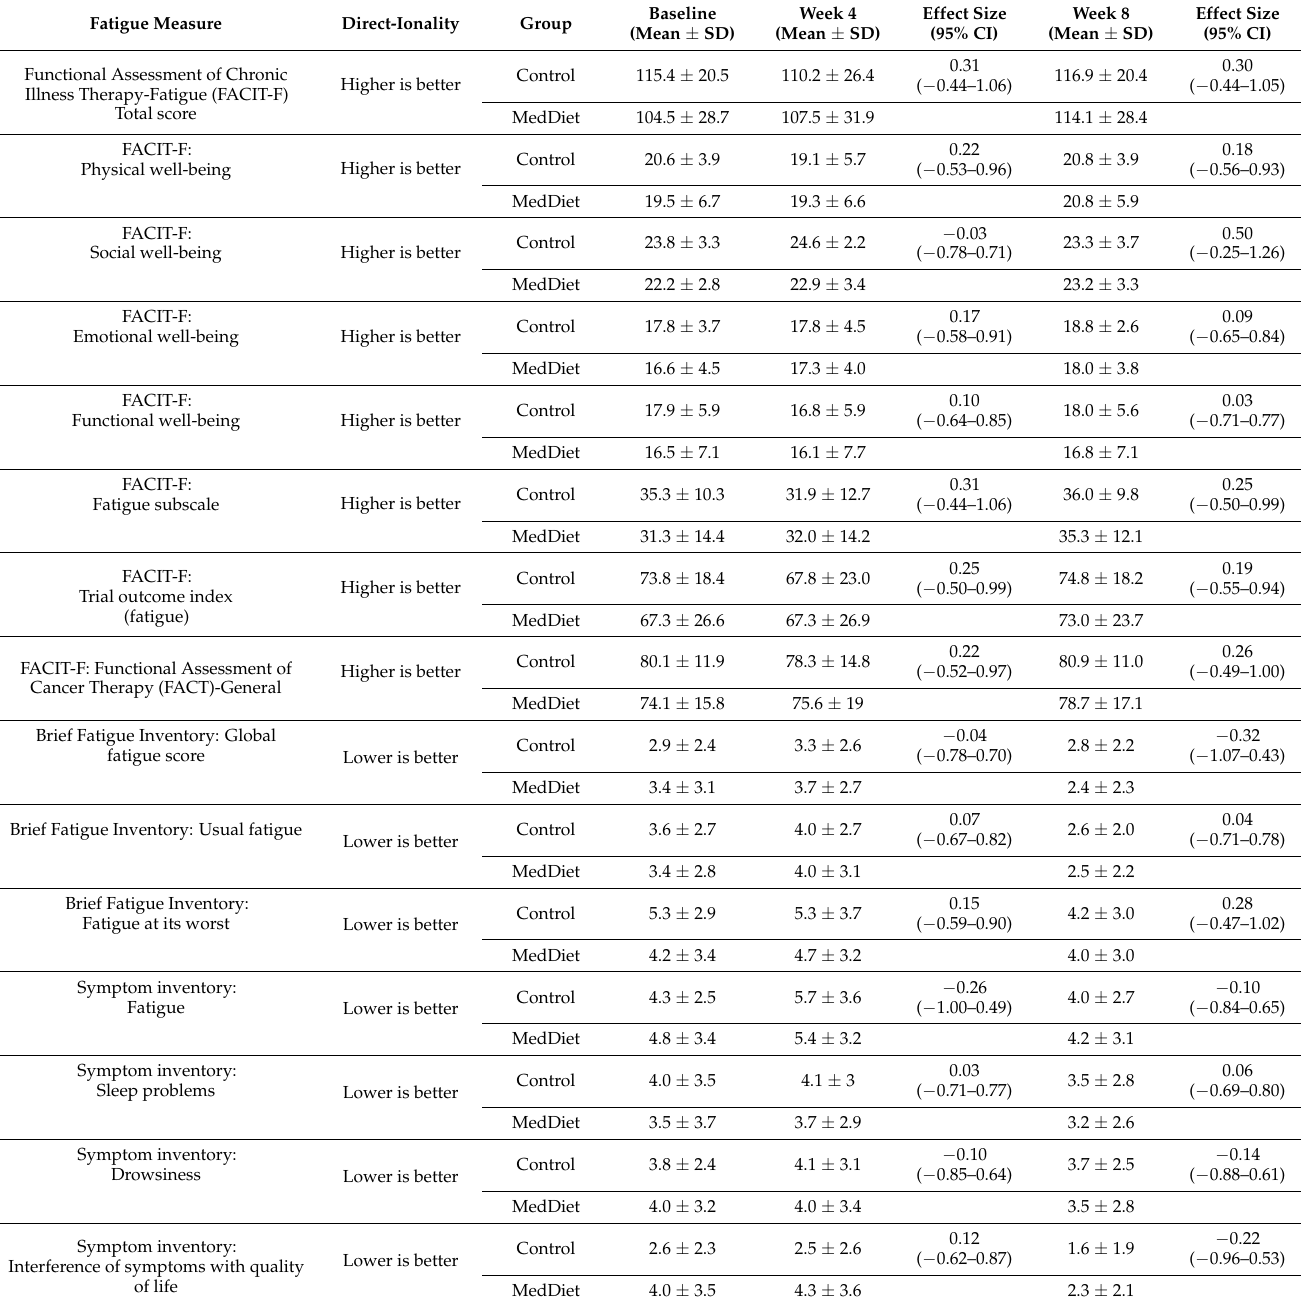
Table 2. The effects of a Mediterranean Diet (MedDiet) intervention on cancer-related fatigue during chemotherapy treatment ( n =